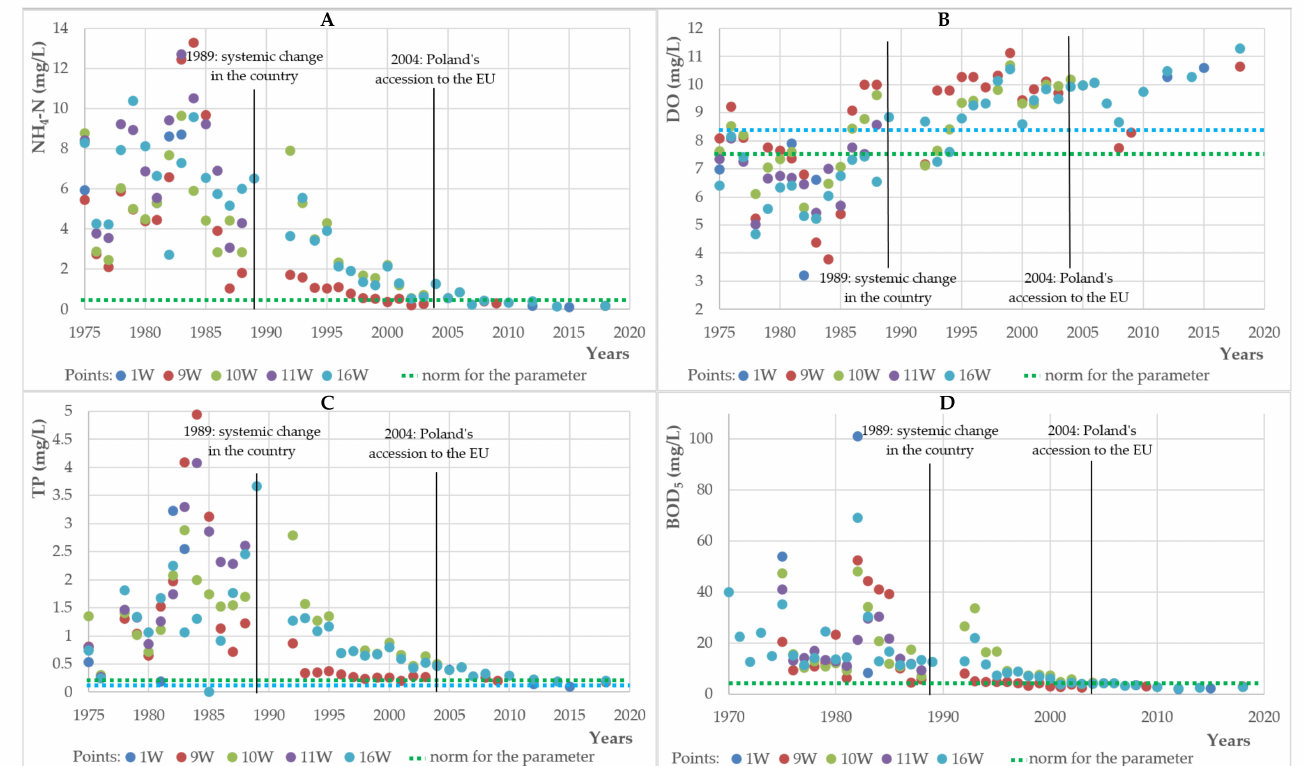
Figure 10. Temporal variability of selected physicochemical parameters (from the top left ( A – D ): NH 4 -N, DO, TP, and BOD 5 ) at monitoring points on the Bystrzyca River, taking into account important events in Poland’s